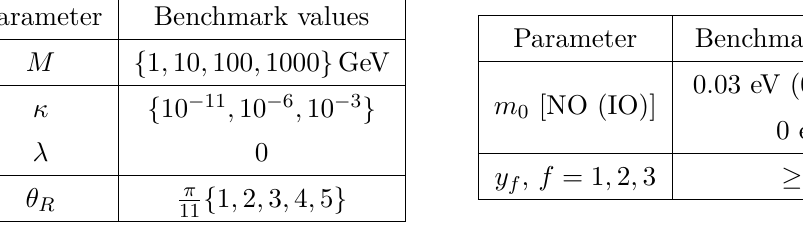
Benchmark values for the free parameters used in this analysis. The rest of the parameters, group theory parameters and the angle θ , is determined as much as possible by one L of the representative examples, found in section 4. The fixed values of the parameters s and v , respectively, are given for each single example in sections